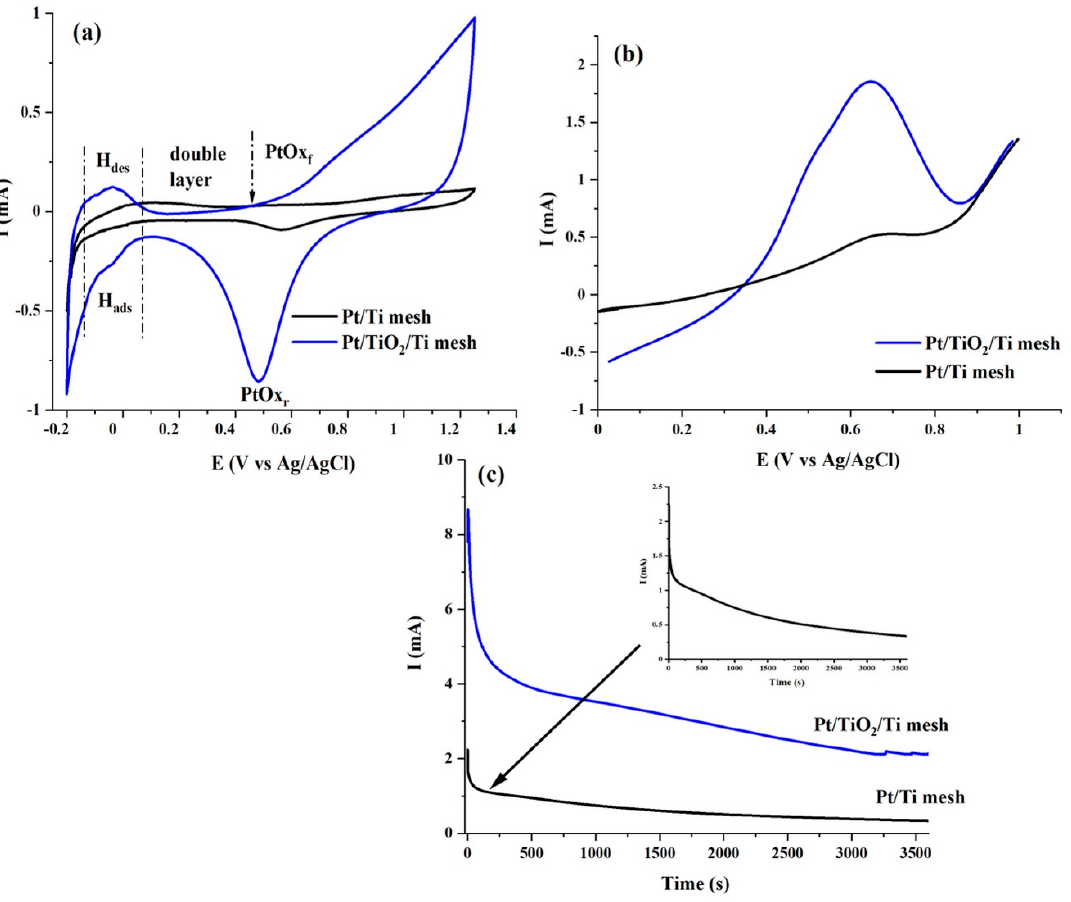
Figure 8. Electrochemical studies ( a ) Cyclic voltammetry in 0.5 M H 2 SO 4 -argon purged solution with a potential scan rate of 50 mV s − 1 . ( b ) Linear scan voltammetry in 0.5 M H 2 SO 4 + 1 M C 2 H 5 OH solution with a potential scan rate of 5 mV s − 1 . ( c ) Chronoamperometry in 0.5 M H 2 SO 4 + 1 M C 2 H 5 OH solution.